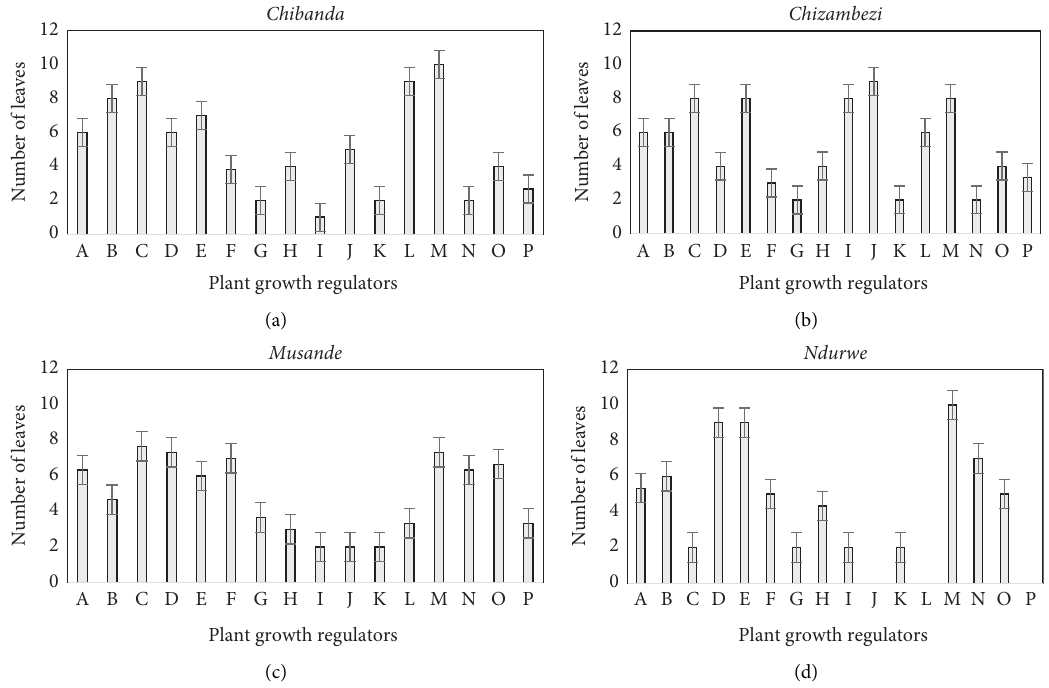
Figure 4: Mean leaf number of the livingstone potato landraces in response to NAA: BAP in mg/l application. P < 0 . 001, LSD � 2.7. Error bars represent standard errors of the differences. Key: A (0mg/l: 0mg/l), B (0mg/l:0.5 mg/l), C (0mg/l:1 mg/l), D (0mg/l:2 mg/l), E (0.2mg/l: 0mg/l), F (0.2mg/l: 0.5mg/l), H (0.2mg/l: 2mg/l), I (0.5mg/l:0 mg/l), J (0.5mg/l :0.5mg/l), J (0.5mg/l: 0.5mg/l), K (0.5mg/l: 1mg/l), L (0.5mg/l:2 mg/l), M (1mg/l: 0mg/l), N (1mg/l: 0.5mg/l), O (1 mg/l:1mg/l), and P (1mg/l: